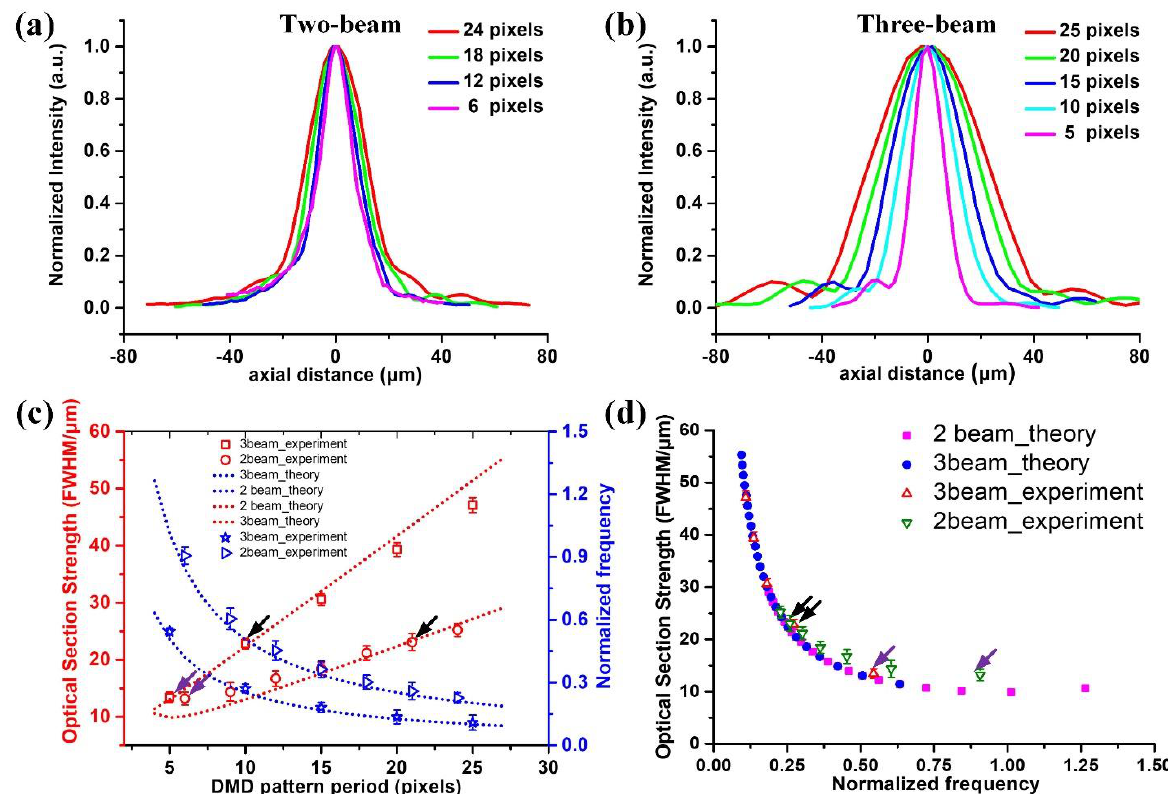
Figure 3. Axial responses at various pattern periods for two-beam ( a ) and three-beam ( b ) interference modes. ( c ) The measured and theoretical FWHMs of the axial response and normalized frequency present as a function of pattern periods for two-beam (red circle and blue triangle) and three-beam interference modes (red square and blue star). ( d ) The measured and theoretical FWHMs present as a function of normalized spatial frequency for two-beam (green triangle) and three-beam interference modes (red diamond).